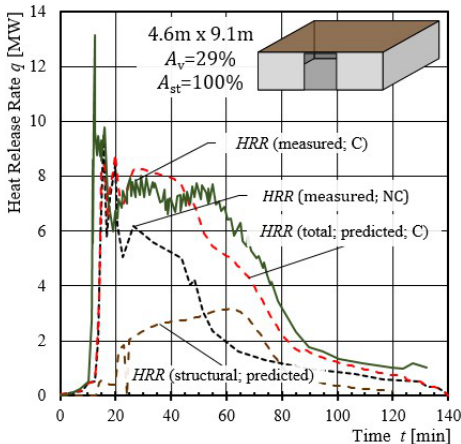
Figure 17: Predicted and measured HRR for experiment IV.